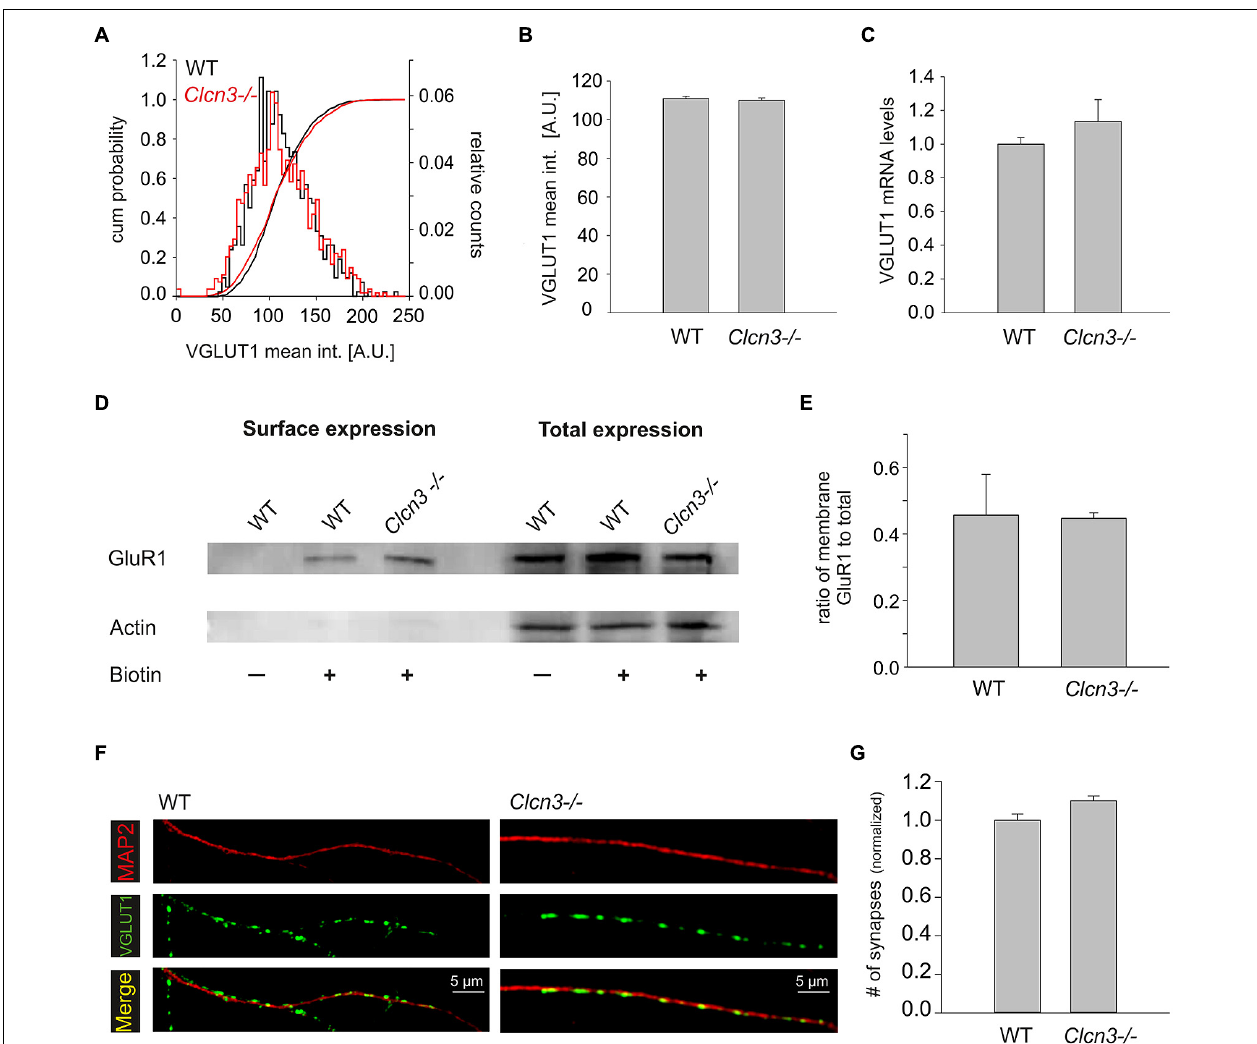
FIGURE 5 | Synaptogenesis and expression of AMPA receptors and VGLUT1 are not altered in Clcn3 − / − neurons. (A) Cumulative mean intensity distribution and superimposed cumulative intensity probability of VGLUT1 staining at synapses for WT and Clcn3 − / − . (B) Mean fluorescence intensity for VGLUT1 staining from Clcn3 − / − ( n = 943 synapses) and WT ( n = 724 synapses, p = 0.6, t- test) synapses. (C) Analysis of the VGLUT1 mRNA levels using quantitative qRT-PCR for WT and Clcn3 − / − neurons (four different cultures, p = 0.52, t -student). (D) Surface and total expression levels of GluR1 in WT and Clcn3 − / −